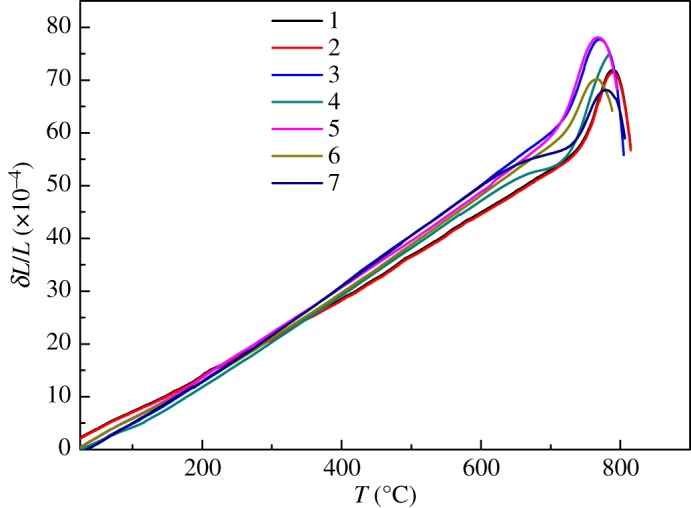
Thermal expansion curves of TFT-LCD substrate glass.